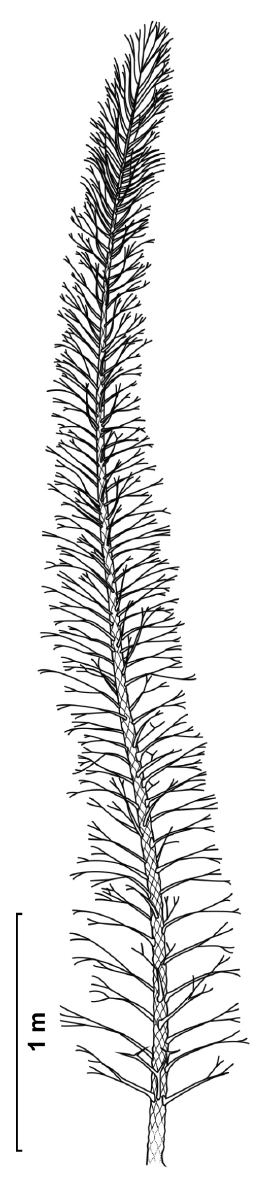
Figure 12. Reconstruction of Dicranophyllum gallicum